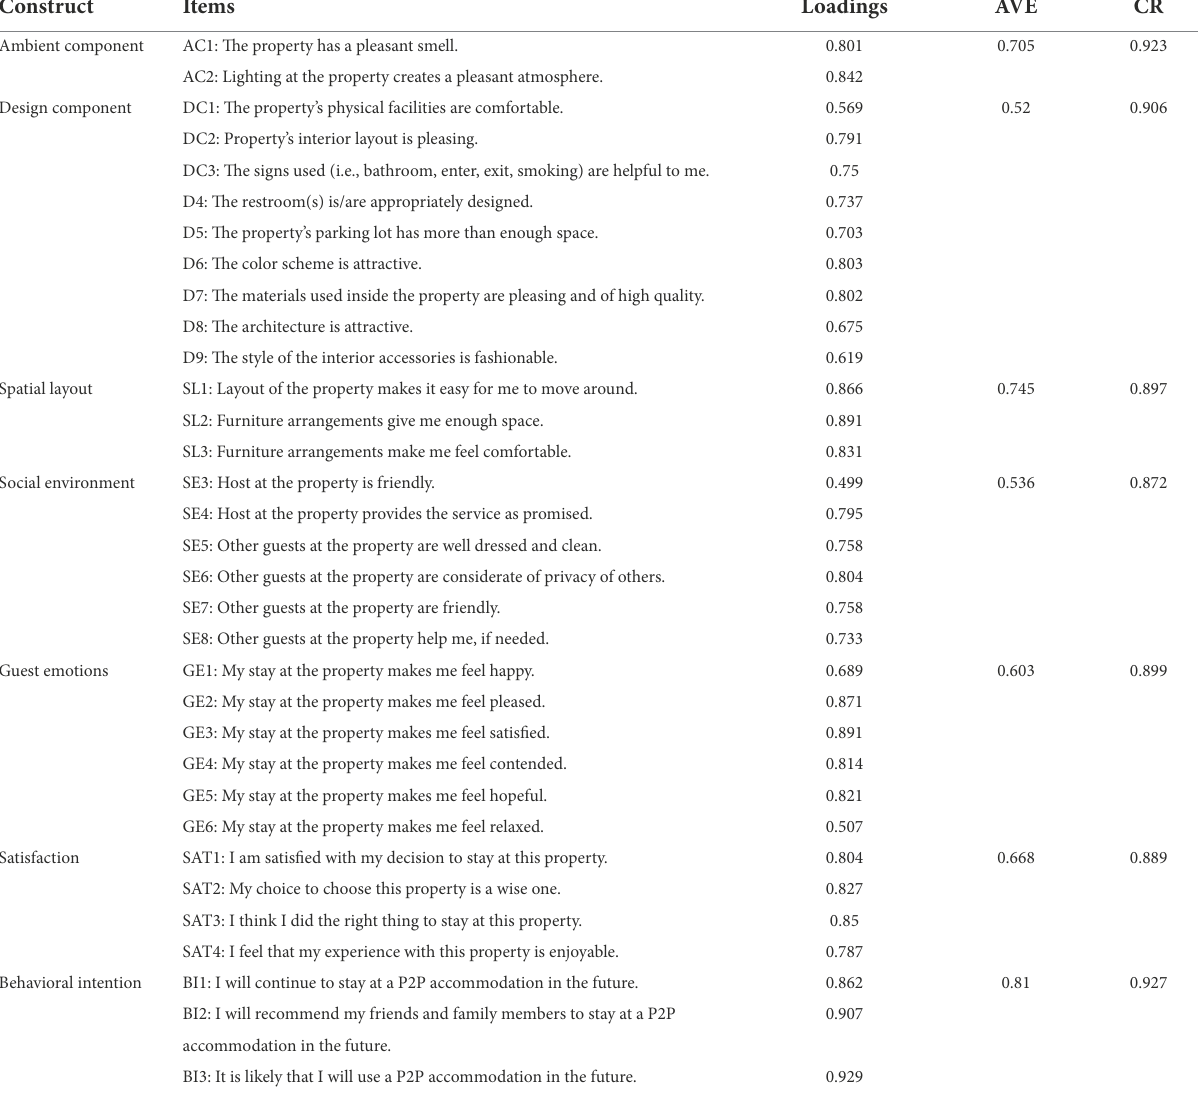
TABLE 4 Results of internal consistency and convergent